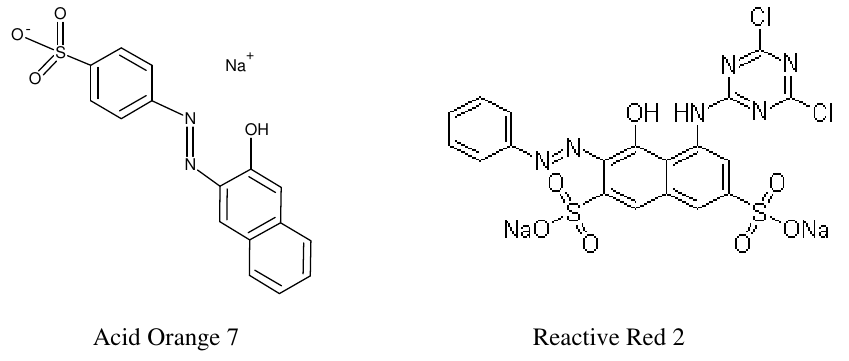
Figure 1. Structural formulae of the